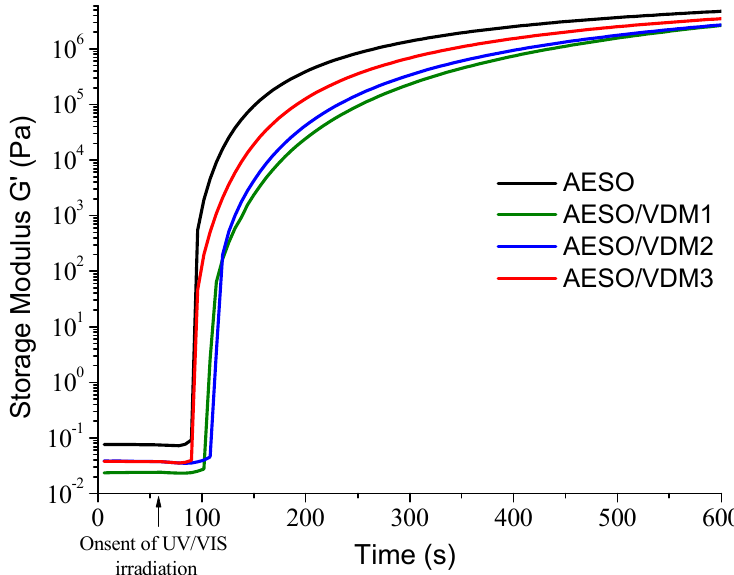
Figure 3. The irradiation time dependencies of the storage modulus G’ of AESO and the resin series AESO/VDM. Polymers 2019 , 11 , x FOR PEER REVIEW